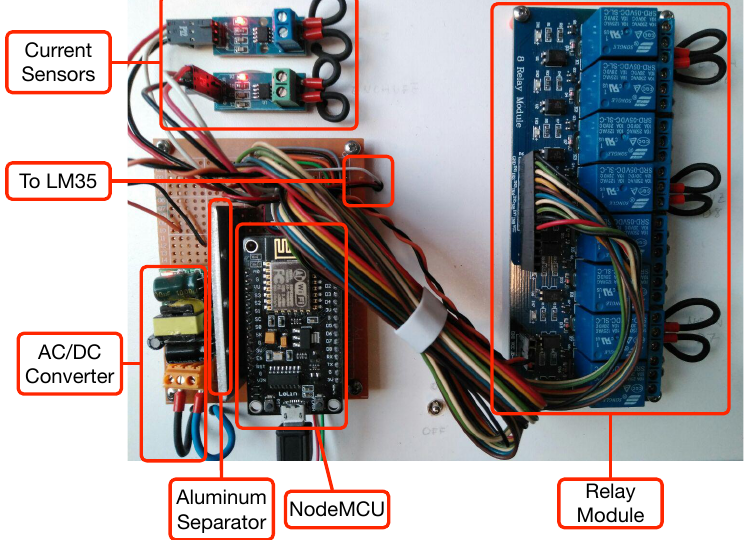
Figure 6. Final prototype of the actuator